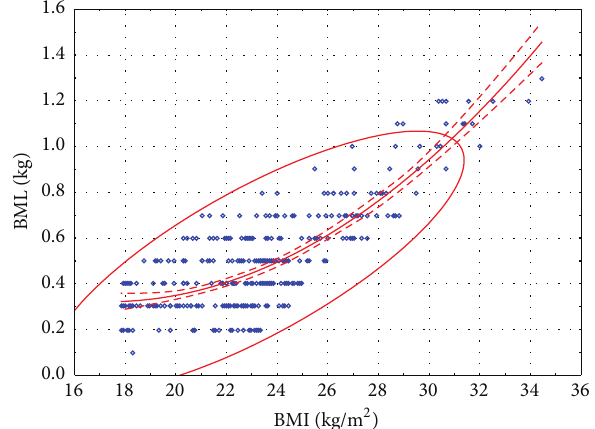
Figure 2: Sauna-induced BML in men from different BMI